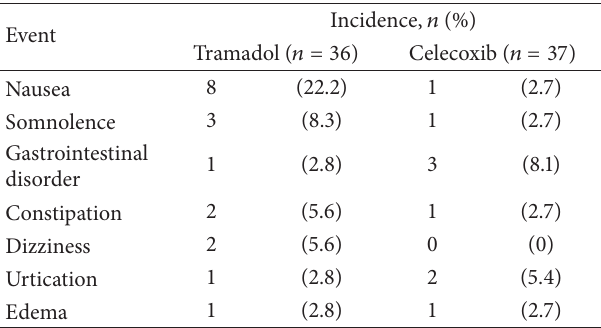
Table 3: Incidence of adverse events related to study